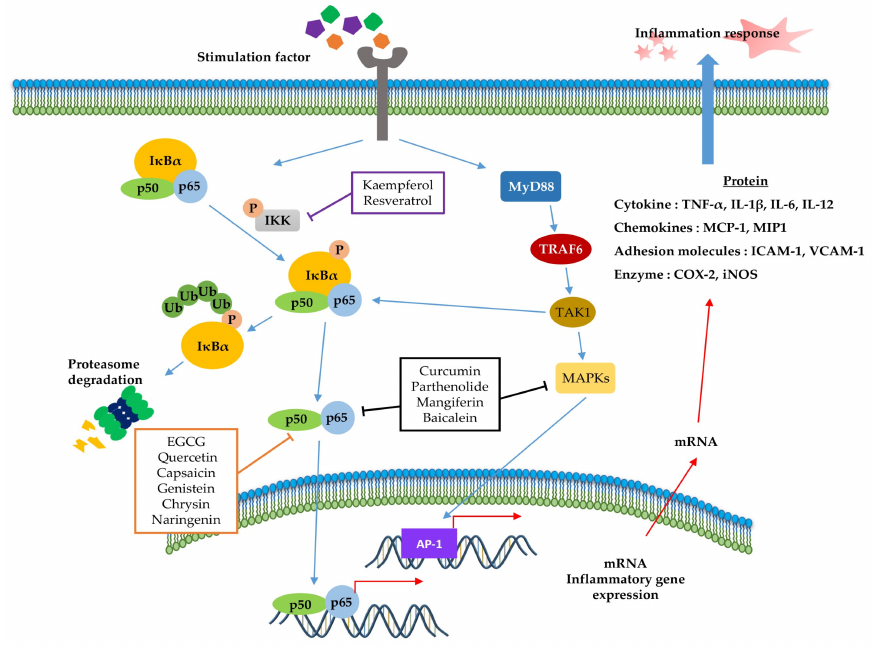
Figure 2. Role of the inflammation-associated transcription factor signaling pathway (NF- κ B) and mitogen-activated protein kinase (MAPK) pathways in the inflammatory response. NF- κ B and